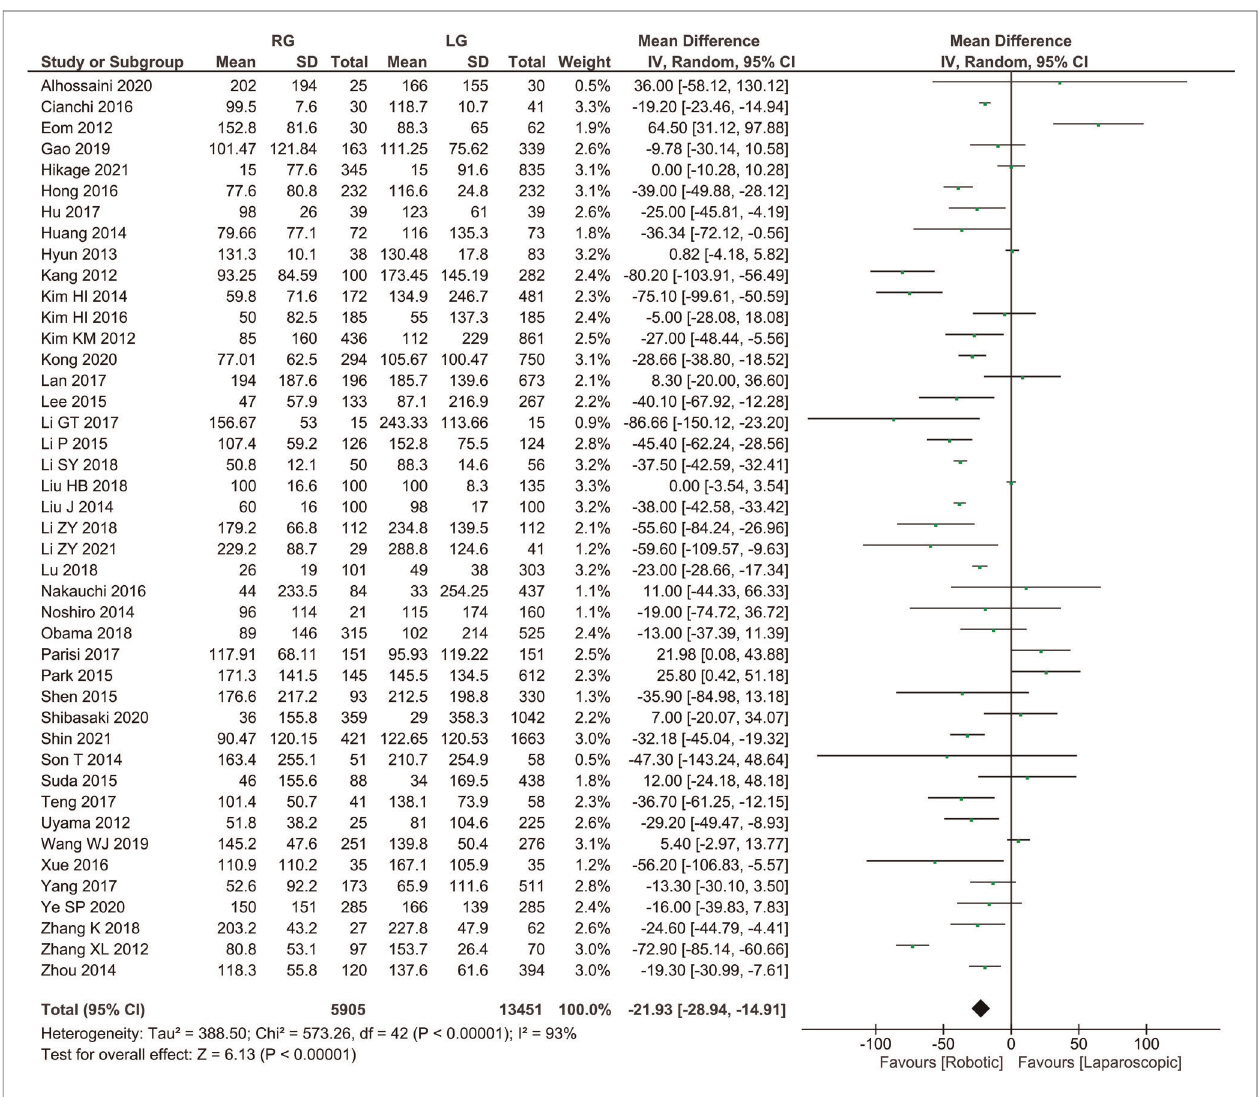
FIGURE 2 | Comparison of intraoperative blood loss between RG and LG